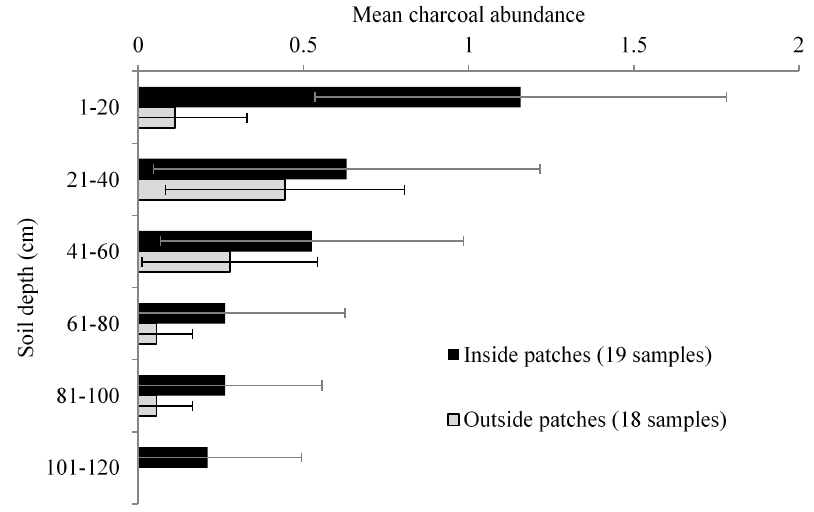
Figure 3. Mean abundance of subsurface charcoal by soil depth and whether belonging to P. elata patches or not. Data collected from 37 auger samples taken in Sites 1–3 (118,052 ha study area, southeastern Cameroon). Means with 95% CI are computed on abundance rates, as defined by